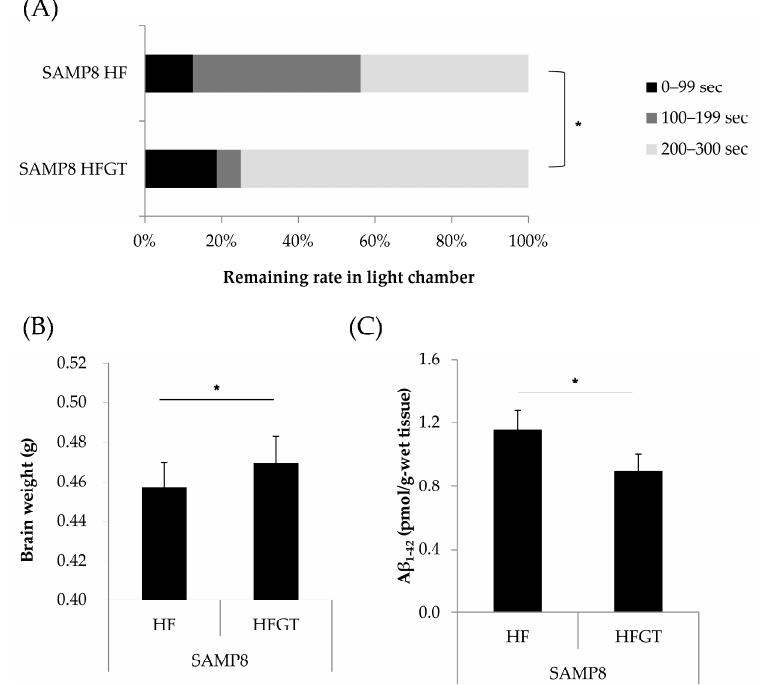
Figure 2. E ff ects of GTEs intake on memory function, total brain weight, and A β 1–42 accumulation Figure 2. Effects of GTEs intake on memory function, total brain weight, and A β 1-42 accumulation in HF diet-fed SAMP8 mice at six months of age. ( A ) Memory retention was measured as in Figure 1A.